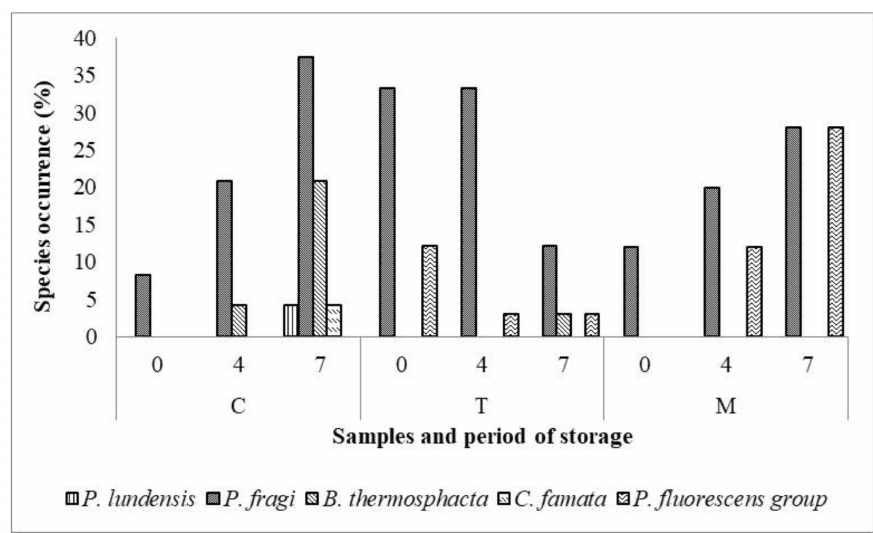
Figure 4. Occurrence (percentage, %) of dominant spoilage species in Tara (T), Mimosa (M) and Control (C) meat samples during the refrigerated